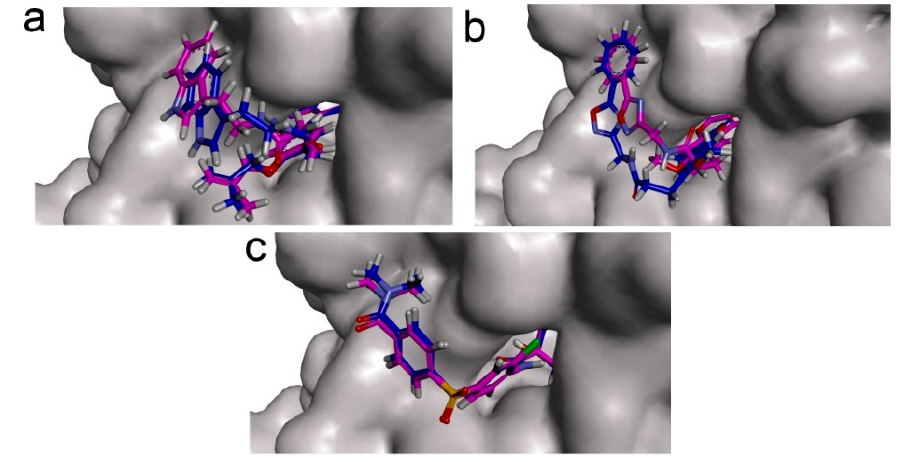
Table 7. Binding energy of compounds with PDKs predicted by AutoDock.